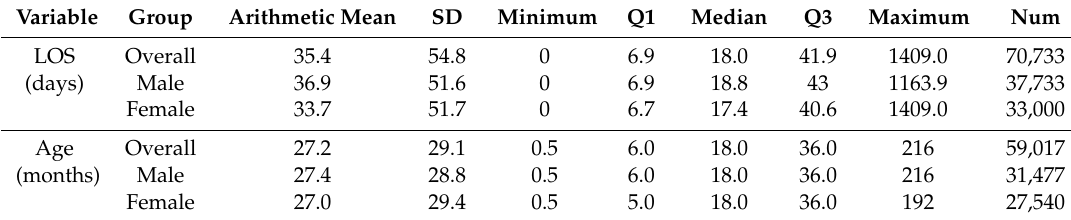
Table 1. Summary statistics for quantitative variables (by sex) in the complete dataset based on 70,733